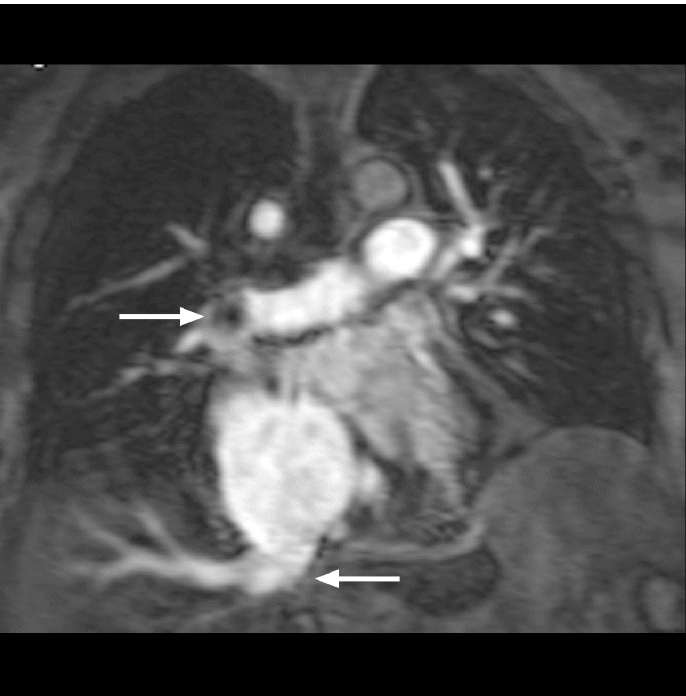
Figure 3. Pulmonary MRA in a 76-year-old male patient. After an initial CT examination and thrombolysis, the MRA control examination showed a residual central thrombus in the right pulmonary artery (upper arrow) with perfusion deficit. Right heart insufficiency with reflux of contrast medium in the inferior vena cava (lower arrow). Moderate examination quality.